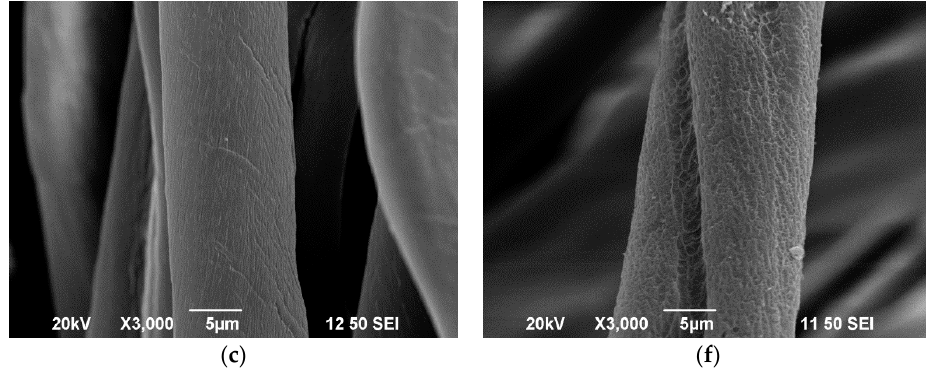
Figure 9. Single jersey fabric: ( a ) grey; ( b ) scoured; ( c ) bleached; and plasma-treated with: ( d ) 160 W 0.2 L/min; ( e ) 160 W 0.3 L/min; and ( f ) 160 W 0.4 L/min.